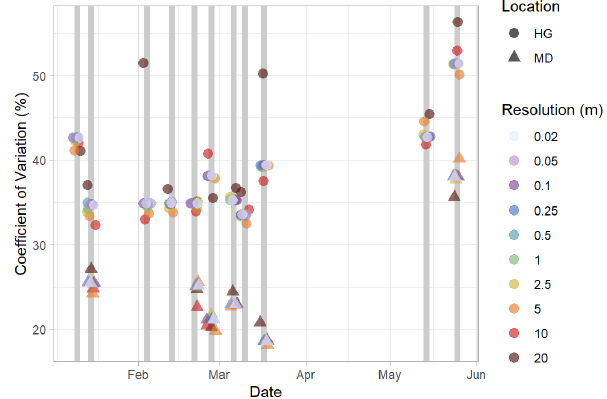
Figure 8. Coefficient of variation values (%) for each observation day at the Hourglass (HG, circles) and meadow (MD, triangles) as calculated from all resolutions (m) of snow depth digital surface models (DSMs) using the nearest-neighbor resampling method. The points are slightly scattered horizontally around the collection dates (grey vertical lines) to allow for clearer viewing and interpretation. Colors represent different snow depth DSM